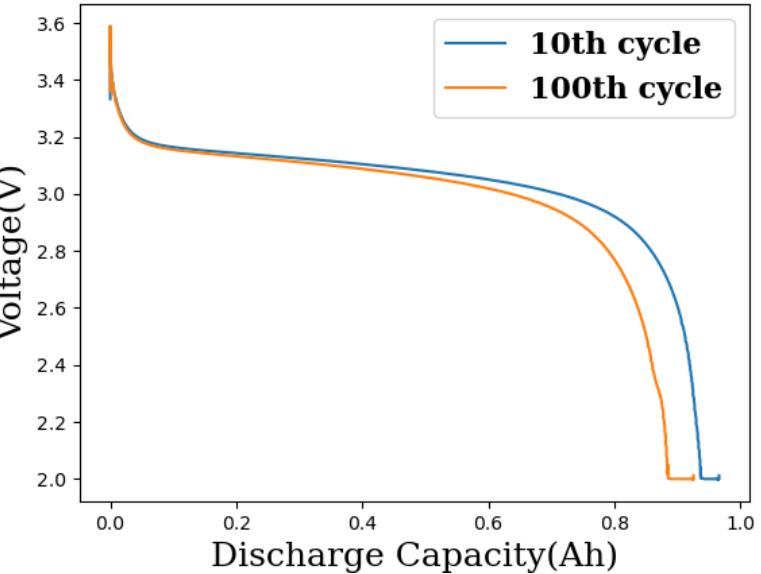
Figure 1. Difference in discharge capacity as a function of voltage between cycle 10 and cycle 100 for an exemplary